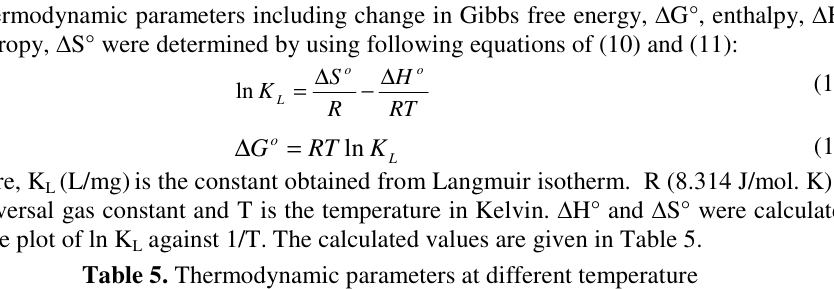
Table 5. Thermodynamic parameters at different temperature Temperature,